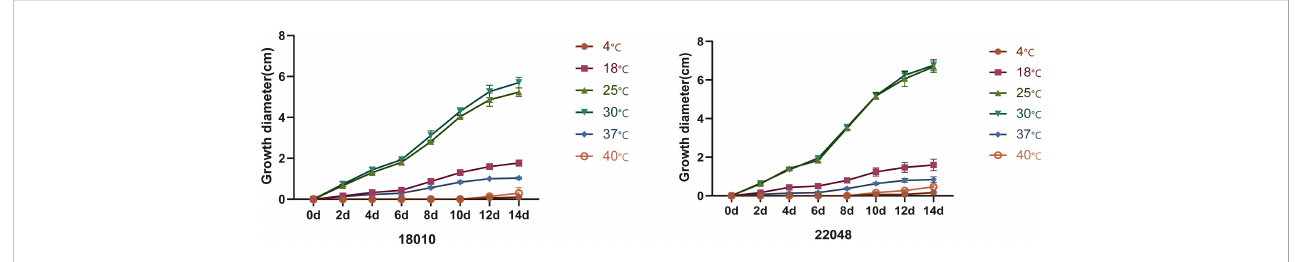
FIGURE 6 Temperature curves of strains JYP18010 and JYP22048 growing on PDA.